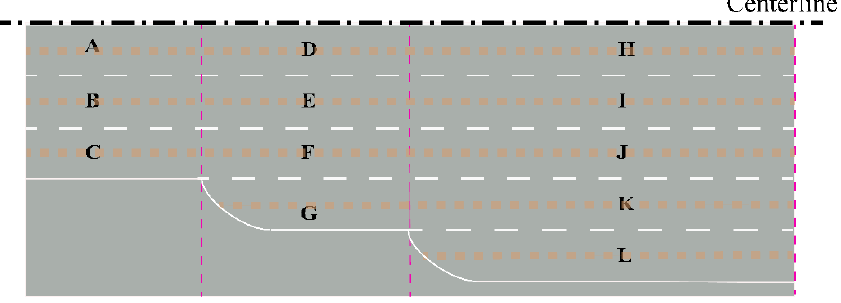
Figure 7. A lane group is shown, which comprises three lane sections that contain three, four, and five lanes, respectively. Each lane is identified by a capital letter from A to L.